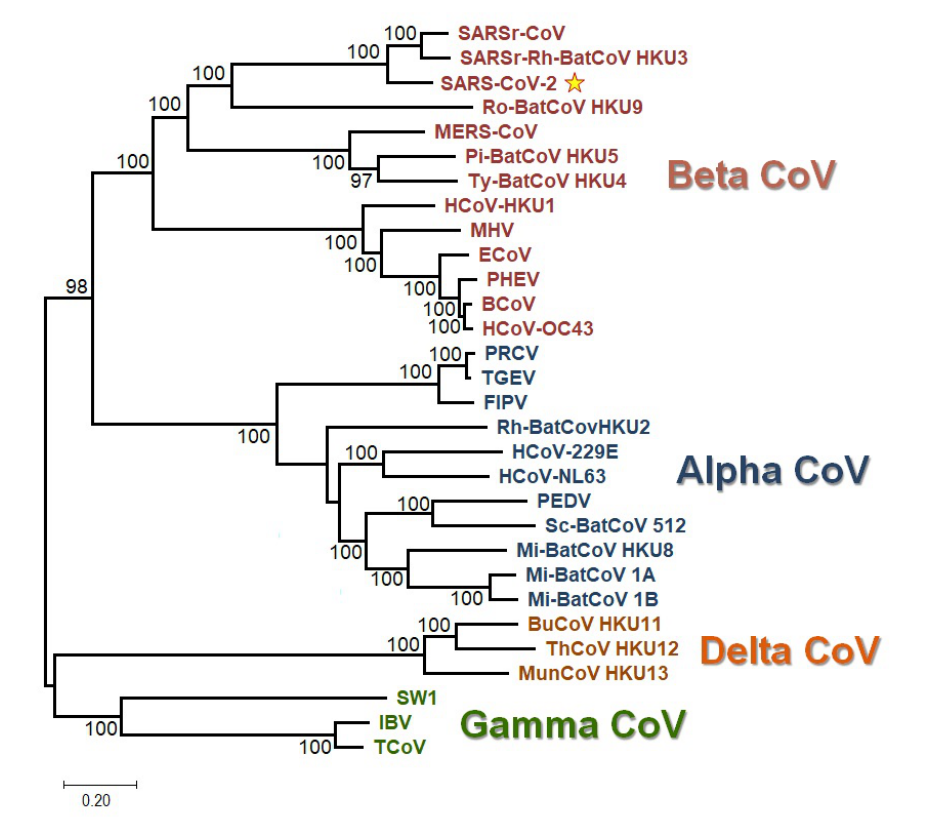
Figure A3. Unrooted ML-based tree of the 30 CoV genomic sequences. The four distinct color-coded clades correspond to the respective genera of CoVs. The SARS-CoV-2 sequence is indicated by a star. The branch lengths depict evolutionary distance. Bootstrap values higher than 50 are shown at the nodes. The scale bar at the lower left denotes the length of nucleotide substitutions per position.